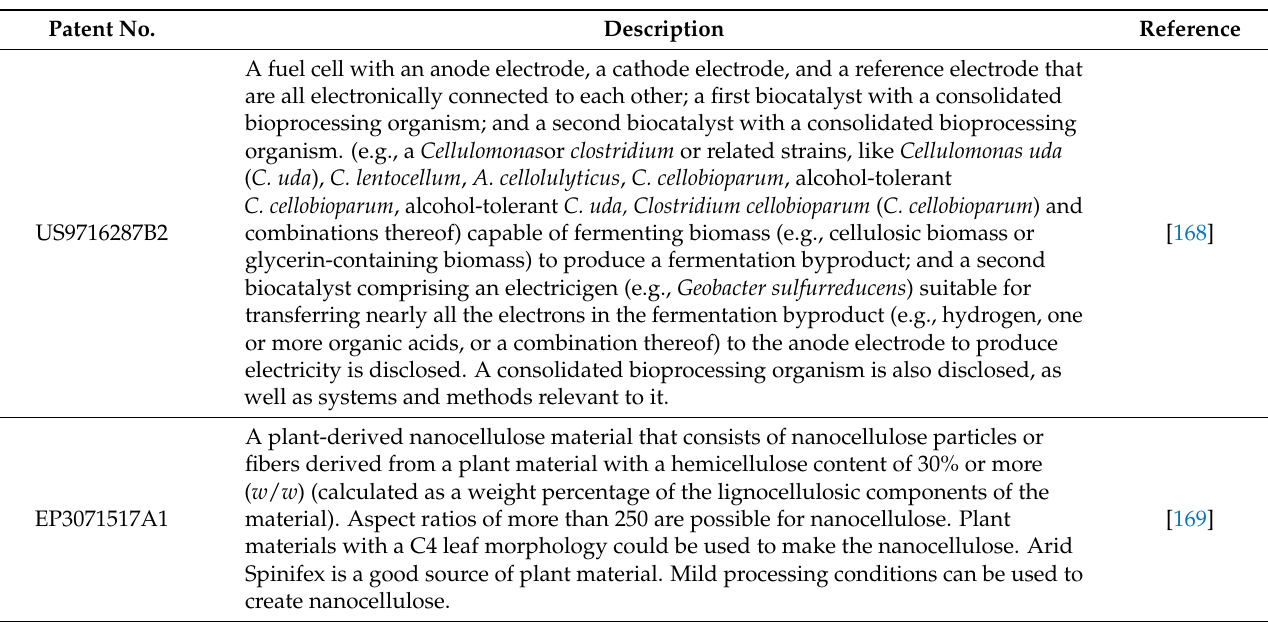
Table 6. Various Patents associated with MFC utilizing Agricultural biomass as substrate. Patent